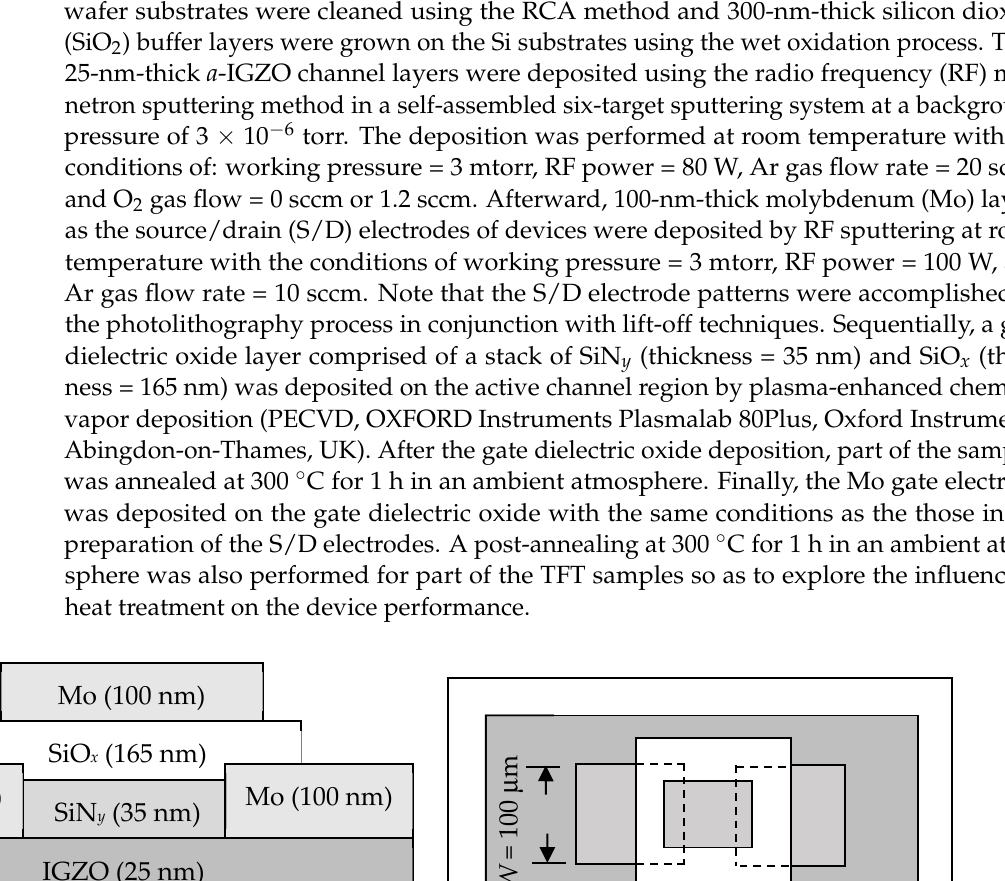
Figure 2. XRD patterns of ( a ) InGaZn 2 O 5 , ( b ) InGaZnO 4 , and ( c ) InGa 2 ZnO 5.5 sputtering targets sin- tered at temperatures from 900 °C to 1300 °C for 6 or 8 h. Figure 2a,b illustrates that the IGZO targets remain as the mixtures of raw powders at a temperature of 900 °C. According to Figure 2a, the InGaZn 2 O 5 phase formed in InGaZn 2 O 5 target at 1100 °C via the following reaction: In 2 O 3 +Ga 2 O 3 +4ZnO → 2InGaZn 2 O 5 (1100 °C)